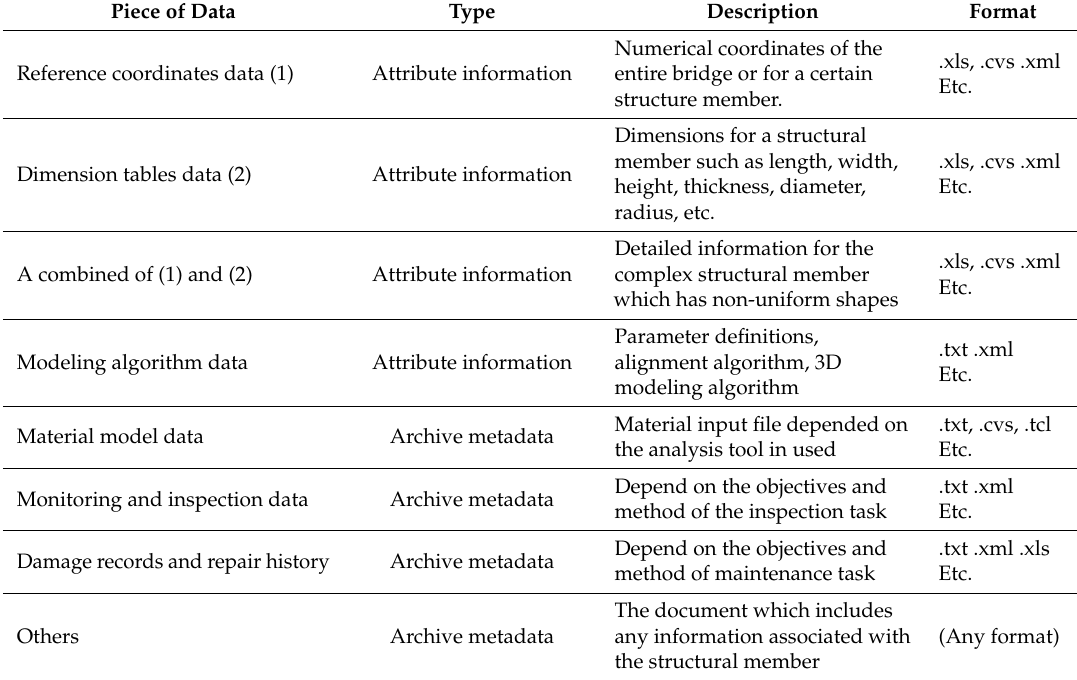
Table 1. Database types in a building information modeling (BIM) model of the suspension